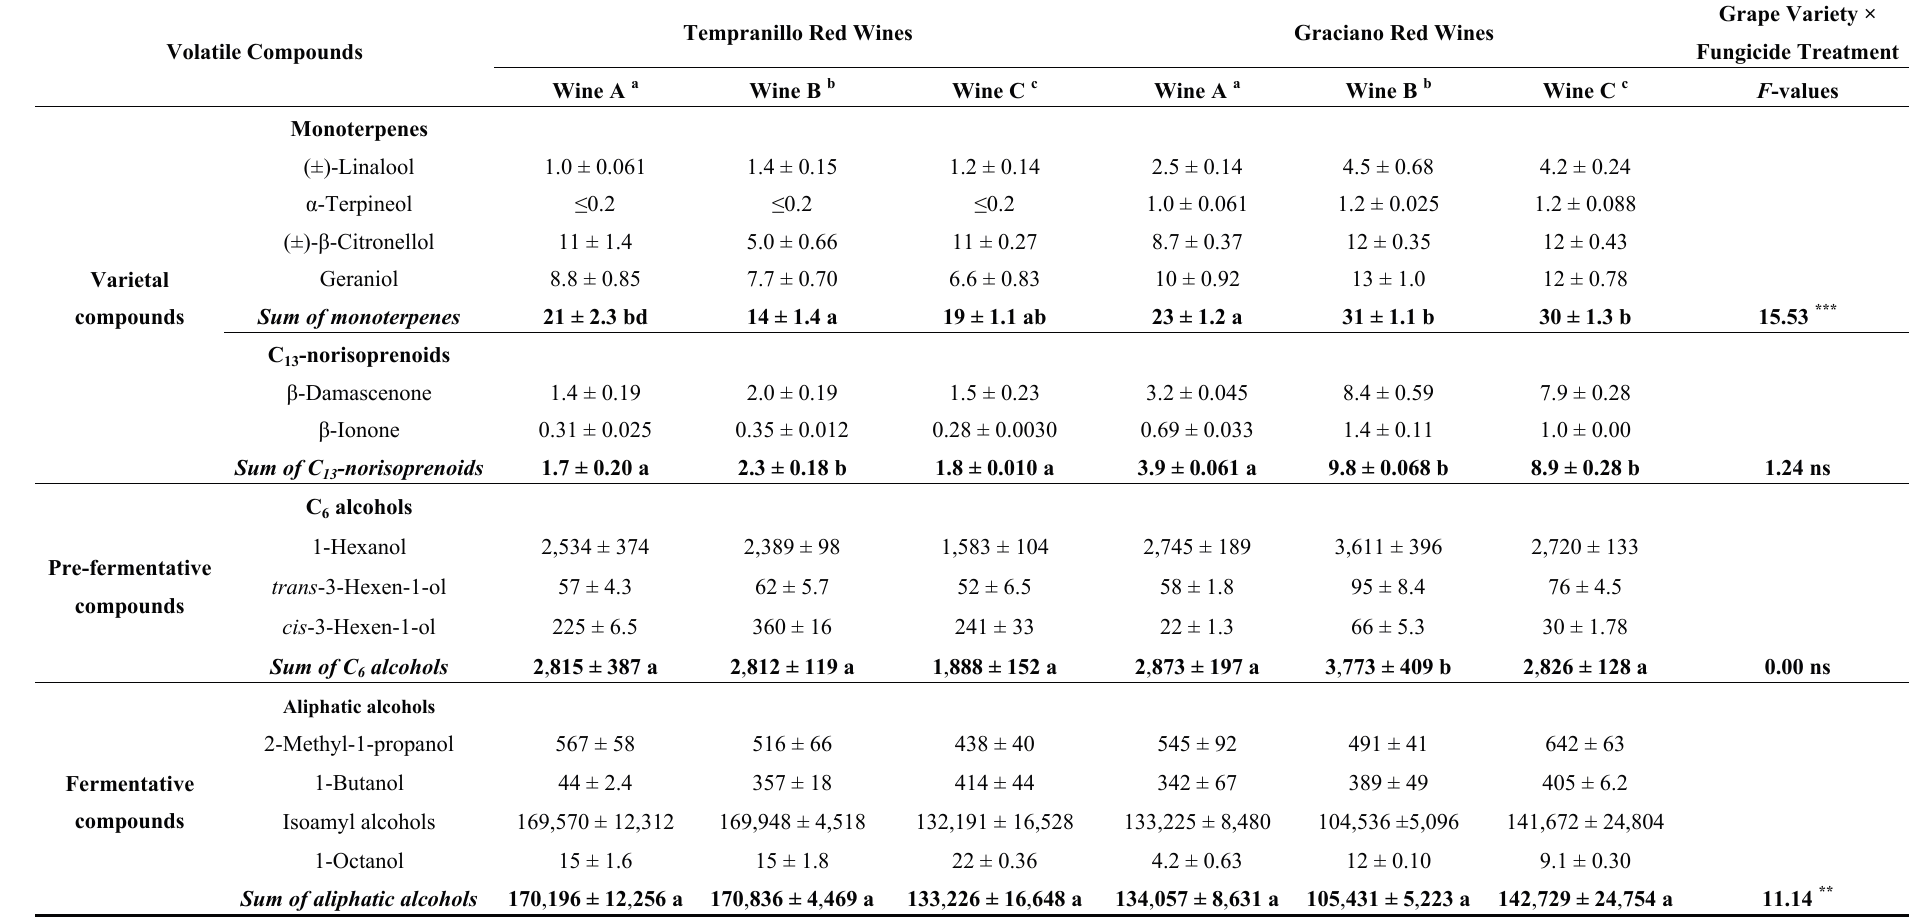
Table 1. Concentration of volatile compounds (µg/L) in Tempranillo and Graciano red wines after fungicide applications (mean values and SD, n = 3